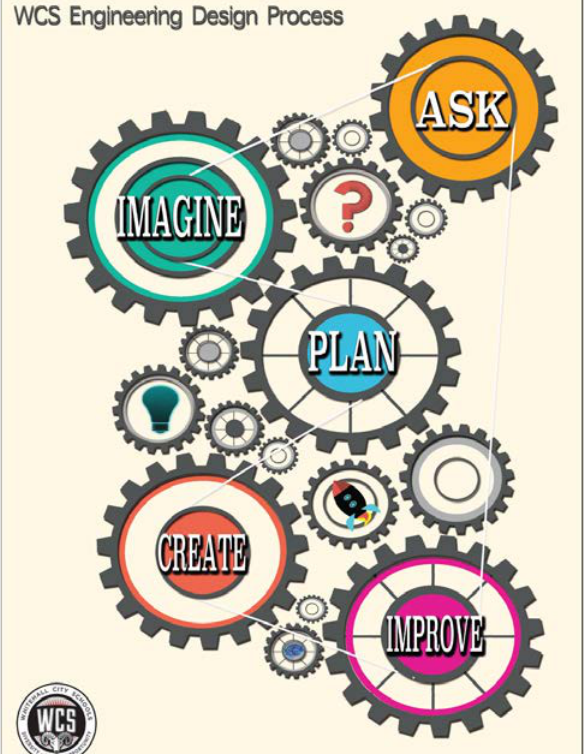
Figure 1. Engineering Design Process developed by Kristy Rothbrush and Whitehall City School District